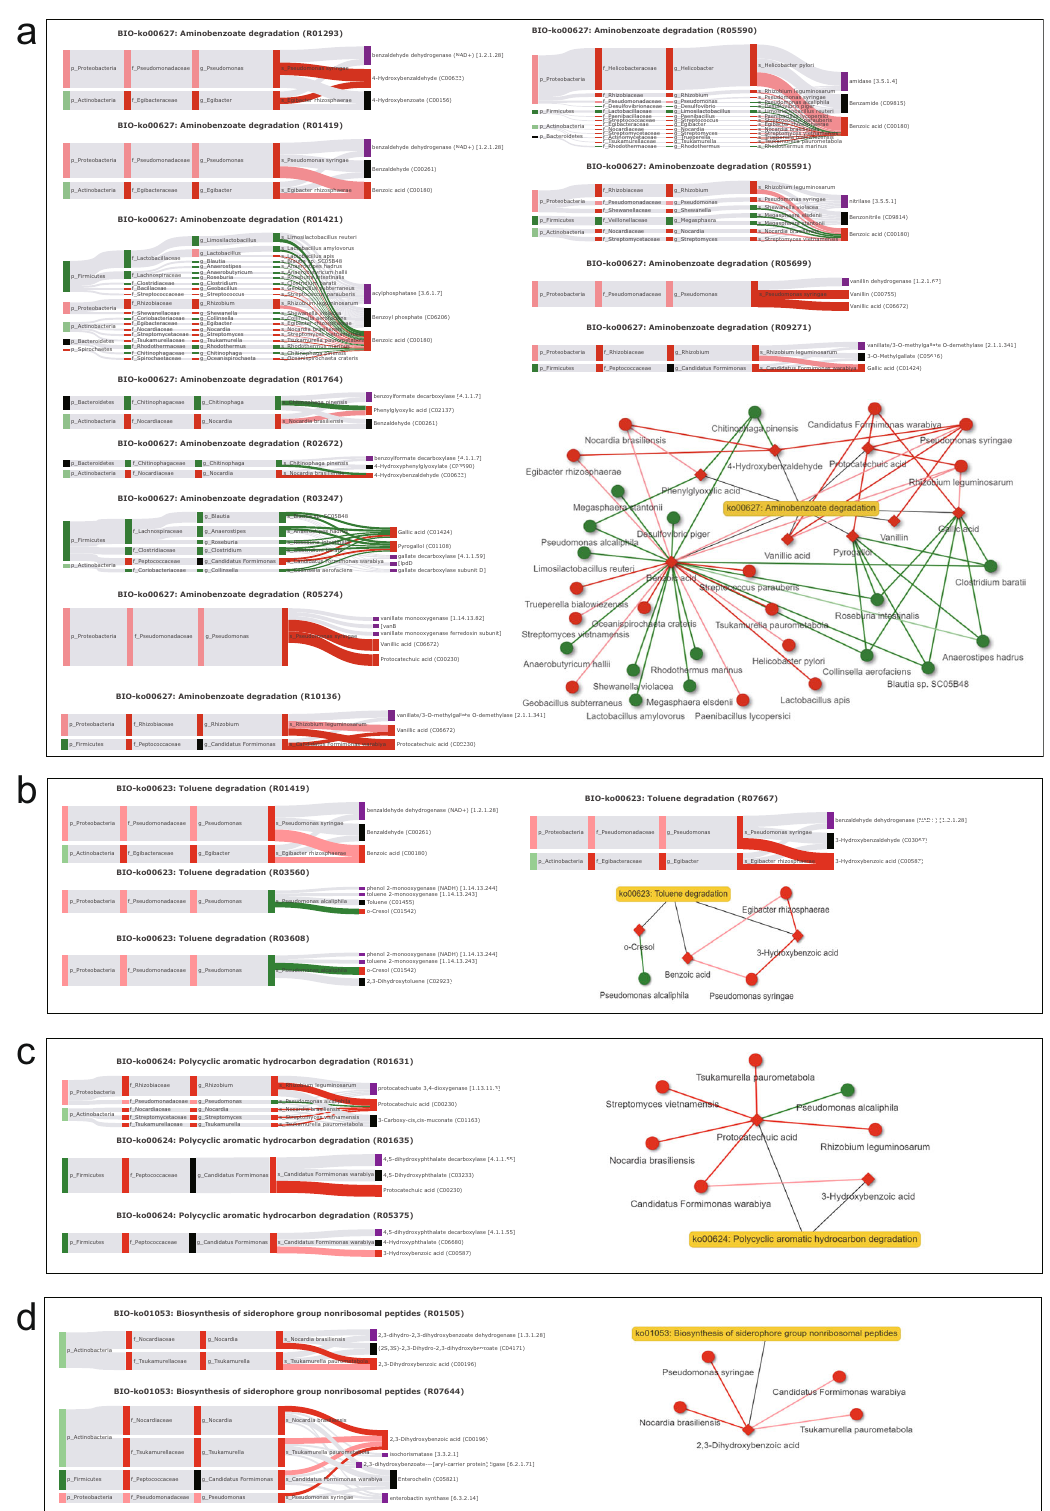
rate of genes related to the DNA replication, base excision repair, nucleotide excision repair, mismatch repair, and homologous recombination pathways was signi fi cantly higher in high-altitude populations. This is consistent with previous studies on Tibetan chickens 44 , blind mole rats ( Spalax carmeli ) 45 , Tibetan